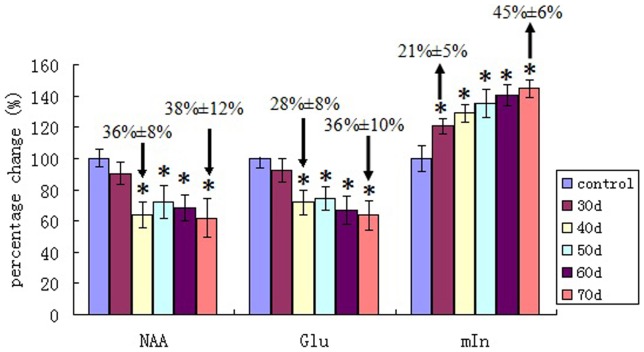
Averaged relative percentage changes of metabolites over six subjects between control mice and senescent mice (Change±s.d).*P<0.01, versus control group. NAA: N-acetylaspartate; Glu: glutamate; mIns: myo-inositol.